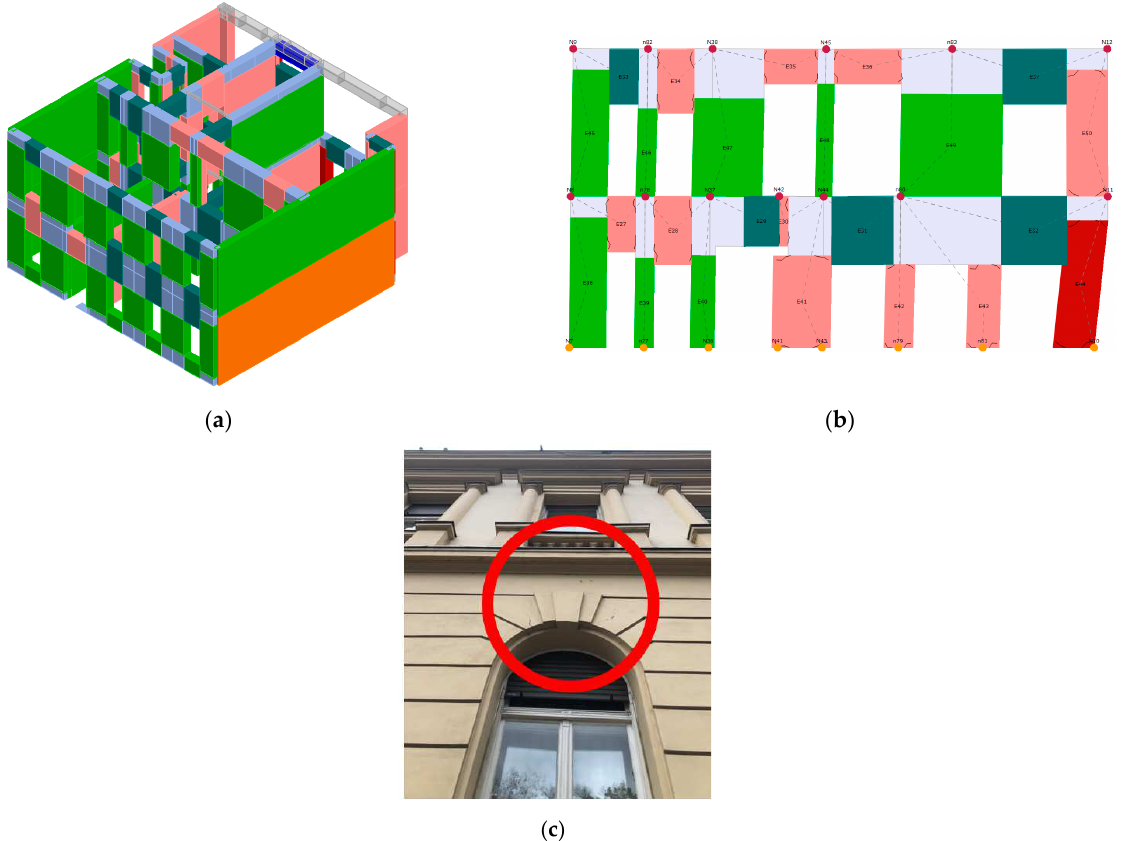
Figure 14. Damage at maximum displacement capacity for pushover in the X direction.